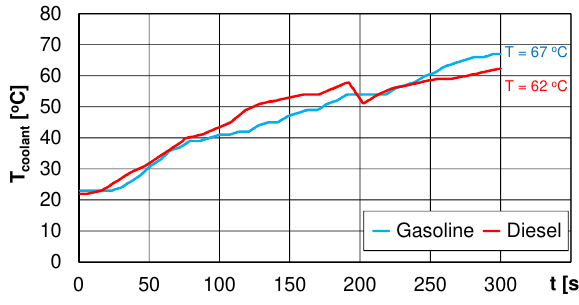
Fig. 8. The coolant temperature during the cold start phase of the gasoline and diesel engines